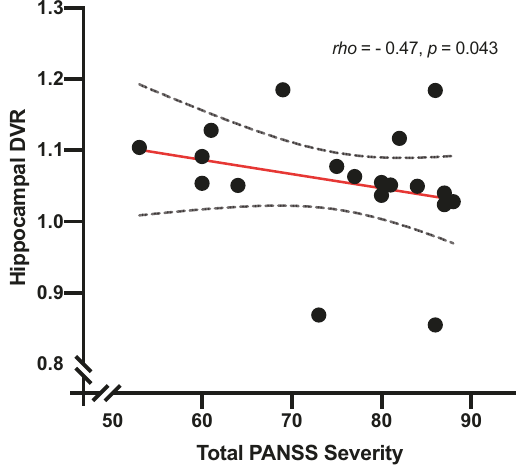
Fig. 3 Relationship of tracer uptake in the hippocampus, as measured by DVR, and total PANSS symptom severity. Dashed line represents 95% CI.